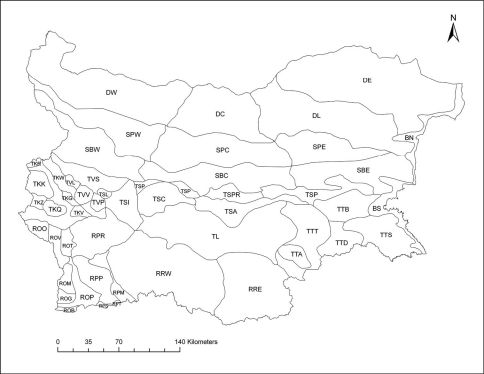
Geographical regions of Bulgaria [after Hubenov (1997) with minor changes and additions]